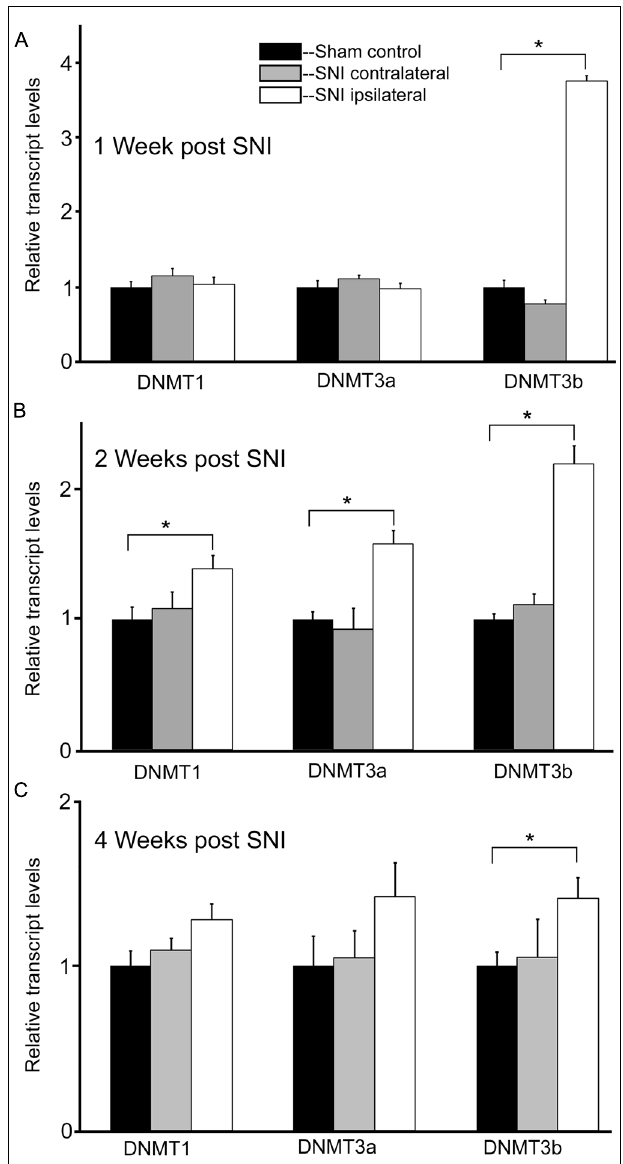
FIGURE 4 | Nerve injury induces a robust and long lasting increase in DNMT3b expression. Gene expression is normalized to GAPDH. All SNI data are normalized to sham controls. (A) At 1 week post nerve injury, qRT-PCR experiments demonstrate a significant, almost fourfold increase in DNMT3b transcript in the DRG ipsilateral to the injured nerve. DRGs contralateral to nerve injury showed no significant changes, * p < 0.001. n = 8 SNI and 8 sham. (B) At 2 weeks post nerve injury, qRT-PCR experiments demonstrate a significant increase in DNMT1 (38%), DNMT3a (58%), and DNMT3b (twofold) transcripts in the DRGs ipsilateral to the injured nerve. DRGs contralateral to nerve injury showed no changes, * p < 0.05. n = 4 SNI and 4 sham animals. (C) At 4 weeks post nerve injury, qRT-PCR experiments demonstrate a significant, approximately 40% increase in DNMT3b transcripts in the DRGs ipsilateral to the injured nerve. DRGs contralateral to nerve injury showed no changes. For DRGs ipsilateral to injury in SNI rats, DNMT1 showed a trend toward being increased by 27% with p = 0.09 while DNMT3a also showed a slight trend of being increased by 42% with p = 0.22, * p < 0.05. n = 6 SNI and 6